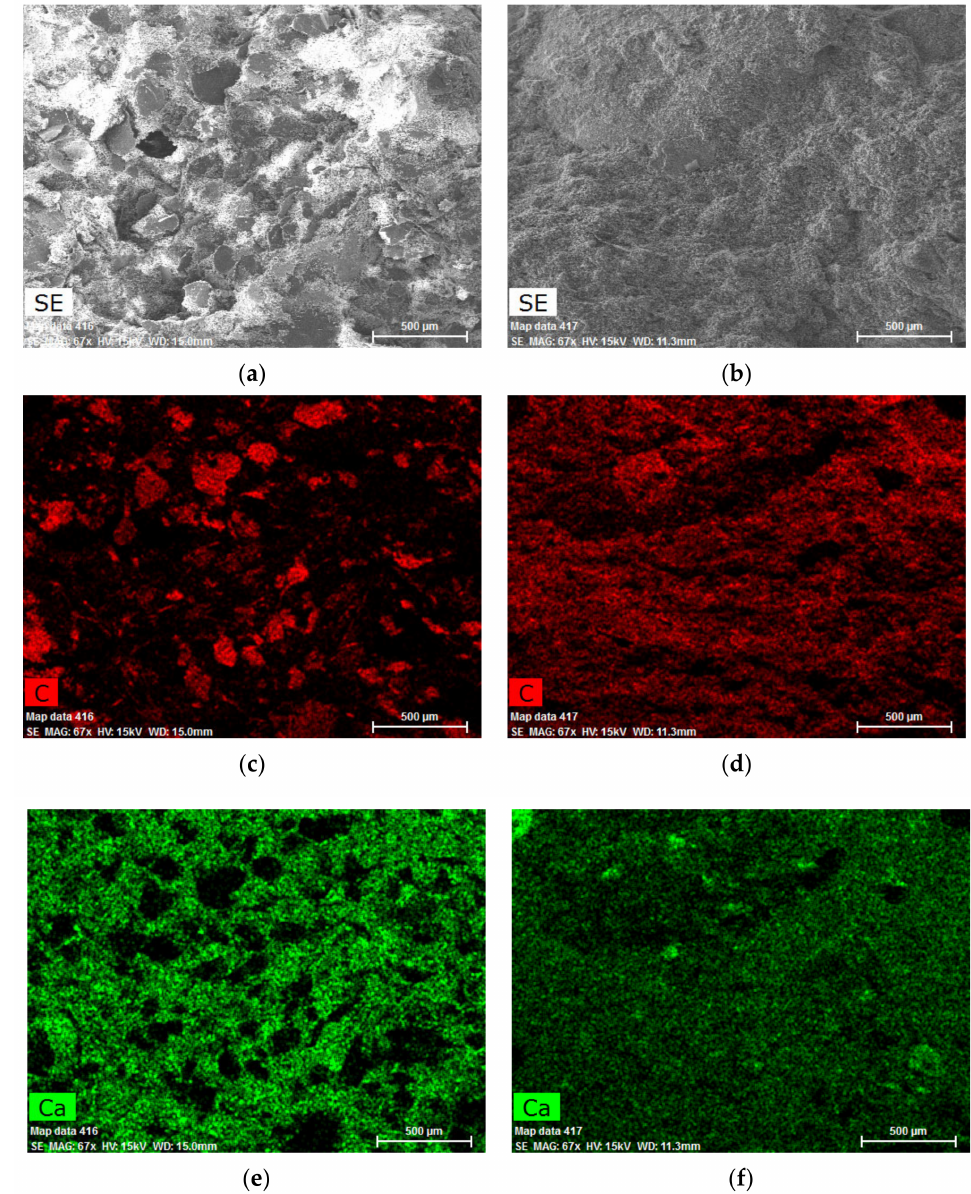
Figure 19. Images from the scanning electronic microscope using the EDX analysis of the cement composites with graphite filler upon 67 × magnification: ( a ) SEM of the surface of the specimen with the Supragraphite C300 filler; ( b ) SEM of surface of a specimen with the Condufit C4 filler; ( c ) the red presence of the carbon in the specimen with the Supragraphite C300 filler; ( d ) the red presence of carbon in a specimen with the Condufit C4 filler; ( e ) the green presence of carbon in a specimen with the Supragraphite C300 filler; ( f ) the green presence of carbon in a specimen with the Condufit C4